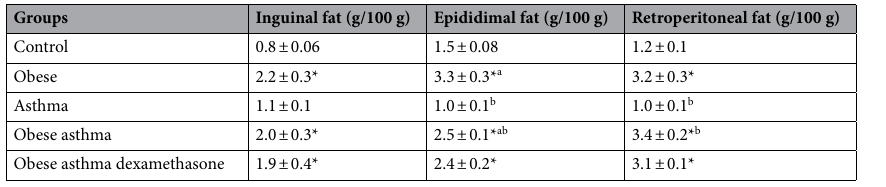
Table 4. Values of inguinal, epididymal, retroperitoneal adipose tissue mass and adiposity index of rats from the Ctrl, Ob, Asth, Ob + Asth and Ob + Asth + Dexa. One-way ANOVA followed by Tukey’s posttest (n = 4–6).